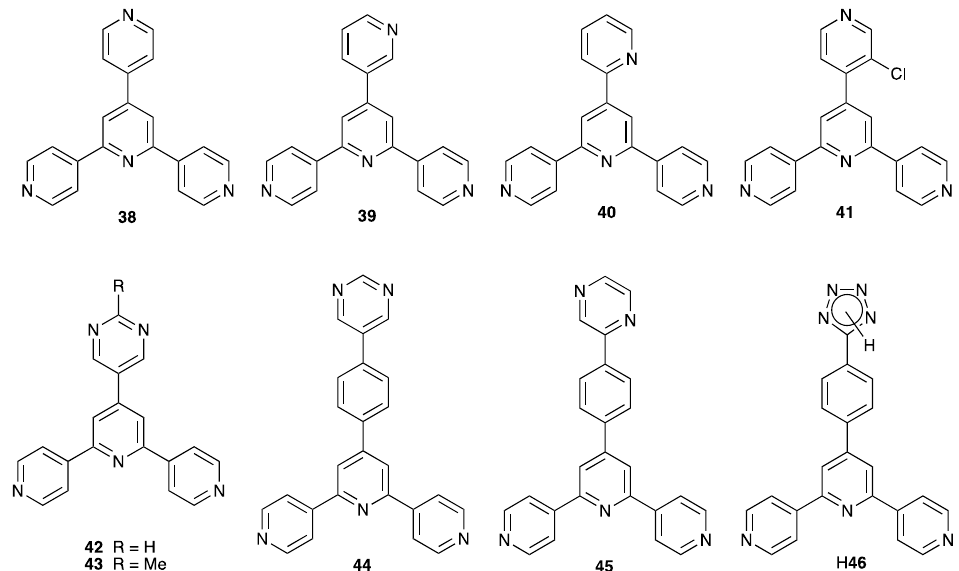
Scheme 11. Structures of 4,2’:6’,4” ‐ tpy ligands functionalized in the 4’ ‐ position with a pyridinyl group or other nitrogen